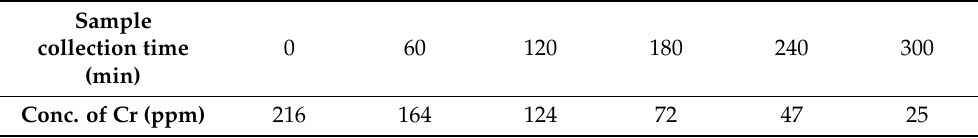
Table 3. Concentration of Cr in ppm, determined by AAS with respect to time of solar photocatalytic